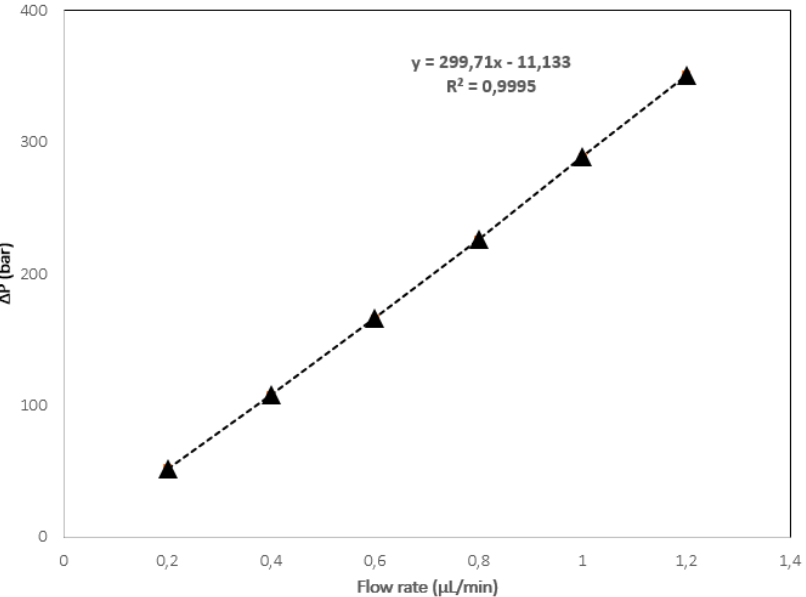
relationship (R 2 = 0.9995) between the flow rate and the back pressure. Figure 3. Van Deemter plot for ethylbenzene as a retained compound using the monolithic column.